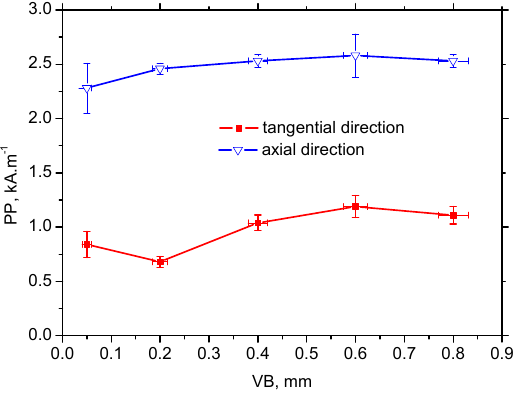
Figure 15. PP of MBN versus VB, PP of MBN for HT surface 0.33 ± 0.08 kA · m − 1 .